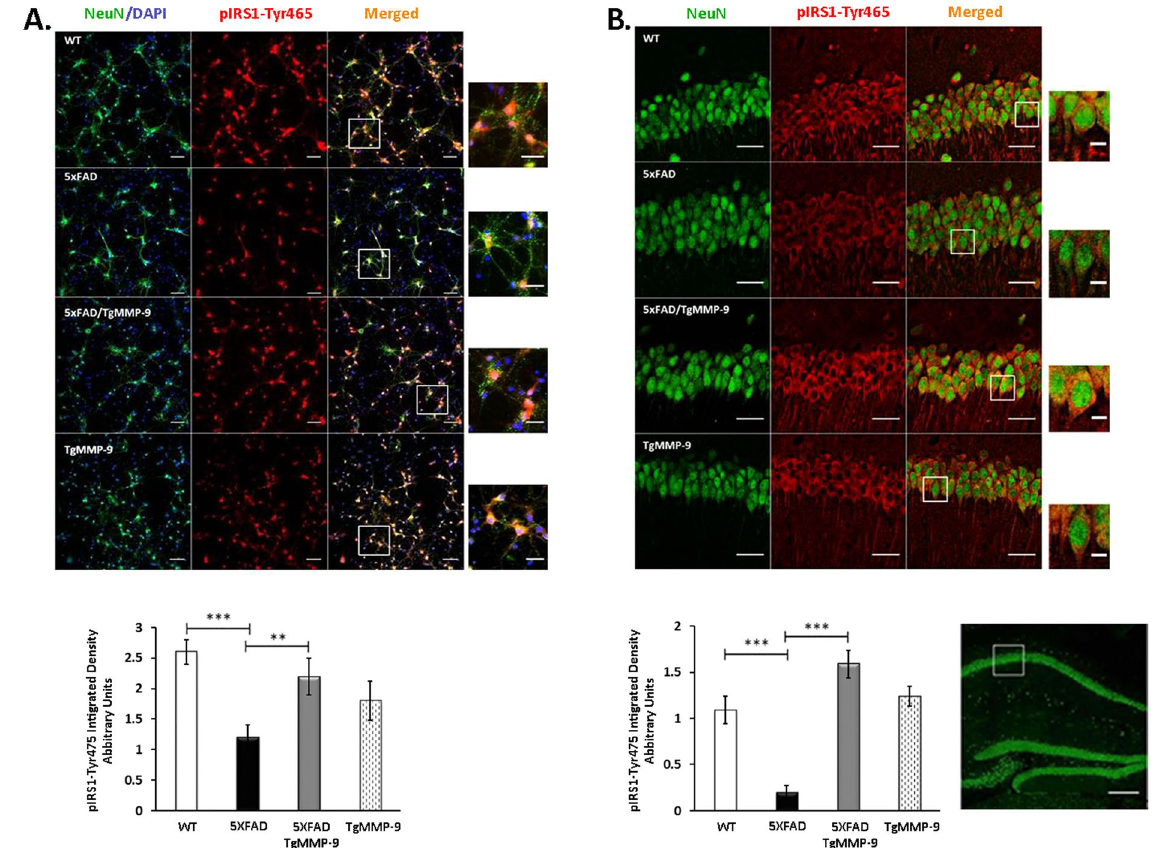
Figure 2. Representative images of primary hippocampal cultures ( A ) and 3 month-old mice CA1 hippocampal area ( B ) of WT, 5XFAD, 5XFAD/TgMMP-9 and TgMMP-9 mice labelled against pIRS1-Tyr465 antibody, depicted in red. Cell nuclei labelled with DAPI are depicted in blue and neurons labelled with NeuN are depicted in green. ( A ) Graph depicts quantification by the integrated density of total pIRS1-Tyr465. Magnification 20x, Scale bar: 50 μ m. Scale bar of white box highlighted areas: 20 μ m. ( B ). Graph depicts quantification by the integrated density of total pIRS1-Tyr465. Magnification 63x, Scale bar: 25 μ m. Scale bar of white box highlighted areas: 5 μ m. Hippocampal overview: Magnification 10x, Scale bar: 250 μ m. n = 3 ( A ), n = 3 ( B ). All data are presented as mean ± SEM ( ** p < 0.01, *** p <